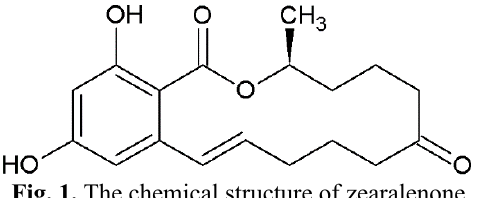
Fig. 1. The chemical structure of zearalenone